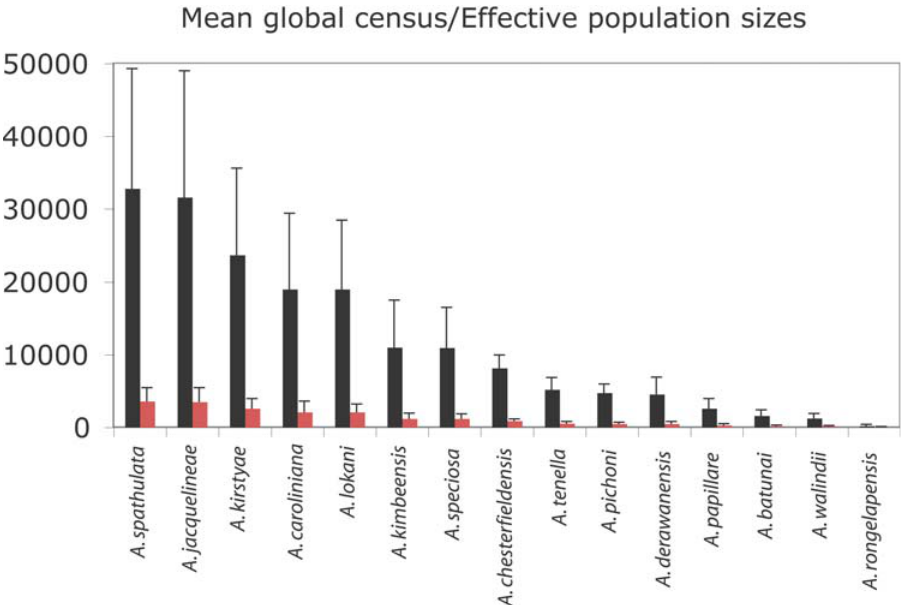
Figure 2. Effective population size data for rare Acropora species included in this study. Mean ( 6 SE) global census sizes are shown as black histograms, and predicted effective population sizes as red histograms. Data for A. tortuosa are omitted, as the mean global census size for this species (Supplementary Table S1) is more than two-fold higher than for A. spathulata (of those shown, the species with the largest global census size).